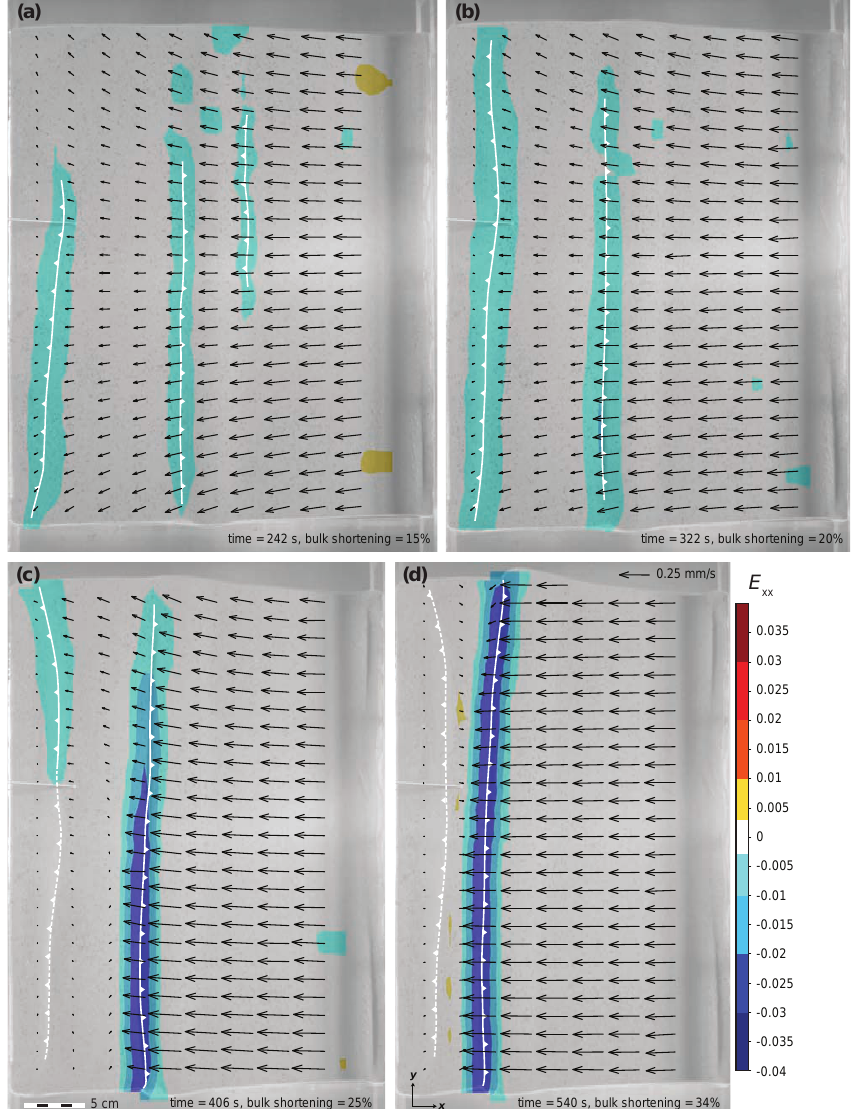
Fig. 12. Views of the model surface in Experiment 3, with the velocity vectors and convergence parallel normal strain E xx . The magnitude of strain is calculated for a time increment of 2s between correlated images. The active faults are drawn with solid line while inactive faults are drawn with a dashed line. The PIV images confirm that the shortening is initially accommodated by a pop-up located above the notch with two opposite verging thrusts rooting near the roof of the notch (a) . The PIV images also reveal that the fault located near the back wall is important at the beginning of the experiment ( a, b ) but becomes inactive while the future main fault develops ( c, d